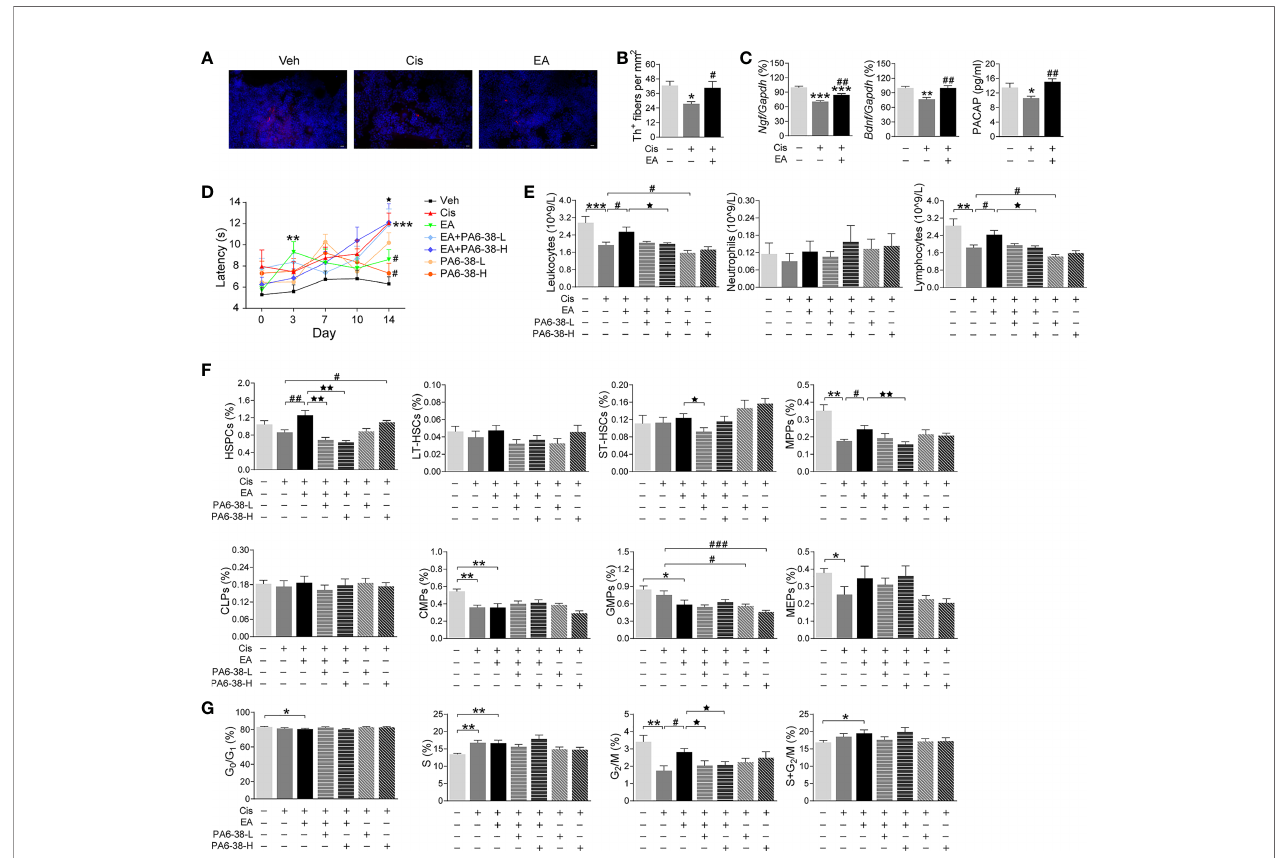
FIGURE 4 | Neurogenic PACAP mediated electroacupuncture-induced protection to cisplatin. (A) Representative immuno fl uorescence images (Scale bar=20.0 m m) and (B) Quanti fi cation of sympathetic Th + fi bers (red) and nuclear (blue) in the BM of the experimental mice ( n= 4 per group). (C) Expression analyses of neurotrophic factors ( Ngf , Bndf : Veh, n =7; Cis, n =6; EA, n =7. PACAP: Veh, n =5; Cis, n =6; EA, n =6). (D) Representation of the latency time (seconds) in hot-plate tests of mice treated with control (Veh), cisplatin (Cis; 3mg/kg), and cisplatin + electroacupuncture (EA) without or with PACAP6-38 (a blocker for PACAP receptor, PAC1) at low (10 m g/kg) or high (100 m g/kg) concentrations (Cis, n =7; other groups, n =8), P values were calculated using two-way repeated-measures ANOVA. (E) Peripheral blood counts of speci fi c subpopulation of leukocytes (Veh, Cis, EA: n =6; other groups, n =7). (F) Analyses of hematopoietic BM subpopulation cells (Veh, Cis, EA, EA +PA6-38-L, EA+PA6-38-H: n =7; PA6-38-L, n =8, PA6-38-H, n =6). (G) Quanti fi cation of PI nuclear staining of BM cells (Veh, n =8; Cis, n =7; EA, n =8; EA+PA6-38-L, n =8; EA+PA6-38-H, n =7; PA6-38-L, n =8; PA6-38-H, n =7). Data are mean ± SEM * P < 0.05, ** P < 0.01, *** P < 0.001 vs Veh; # P < 0.05, ## P < 0.01, ### P < 0.001 vs Cis; ⋆ P < 0.05, ⋆⋆ P < 0.01 vs